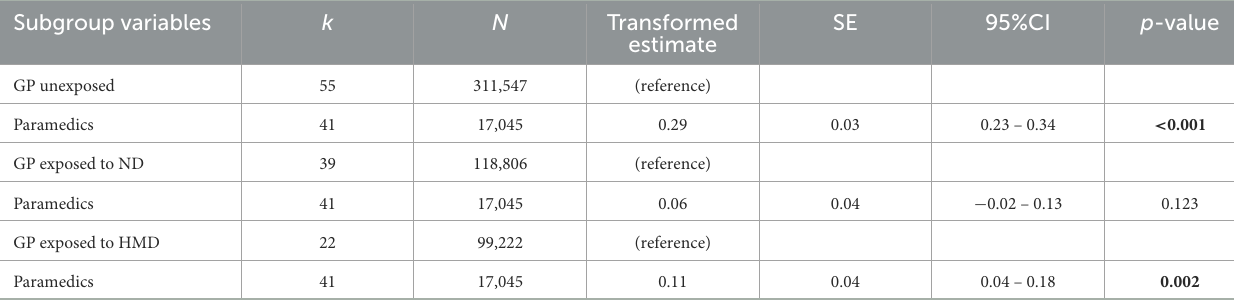
TABLE 2 Pooled prevalence estimates of PTSD in paramedics compared to unexposed and exposed groups of general population to major